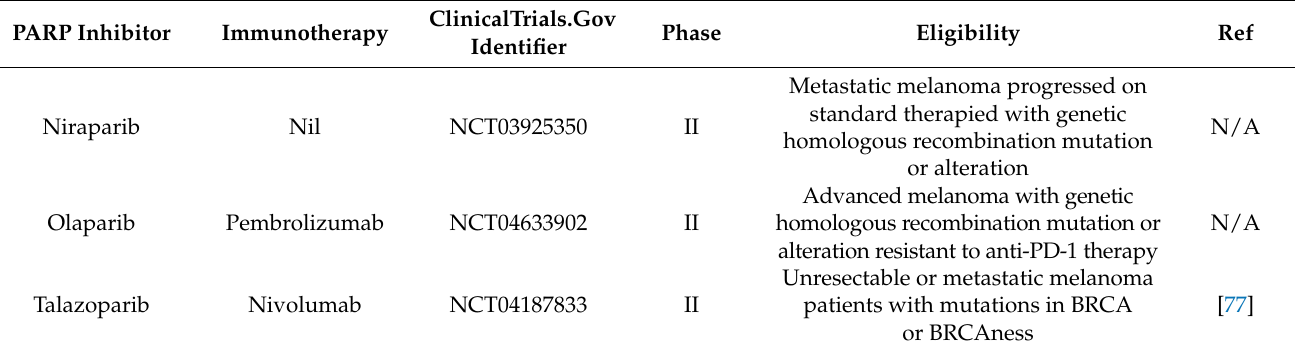
Table 4. Ongoing Trials of PARP inhibitors and Immunotherapy in Melanoma. PARP